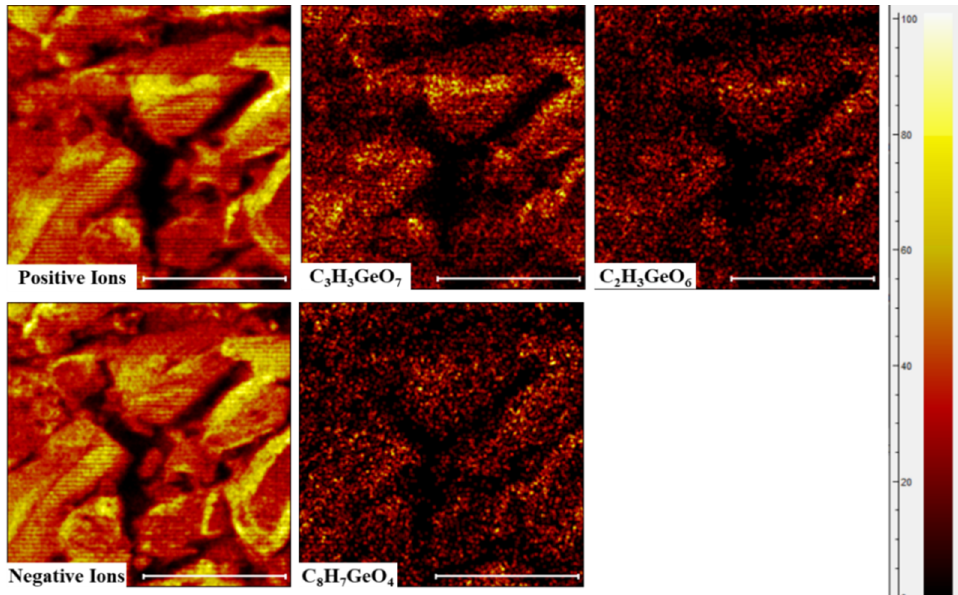
Figure 5. TOF − SIMS images of germanium–tannins complexes. Figure 5. TOF-SIMS images of germanium–tannins complexes.